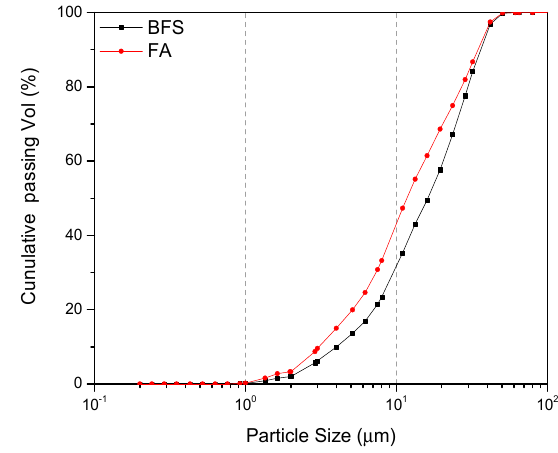
Figure 1. Particle size distribution of raw materials.